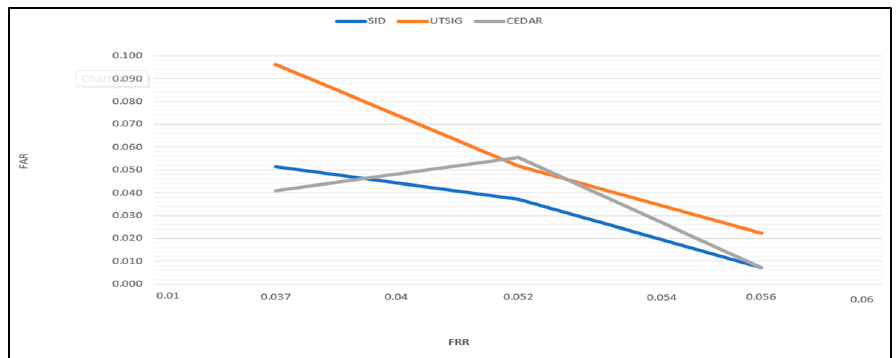
Figure 11. The accuracy in the plot curve.